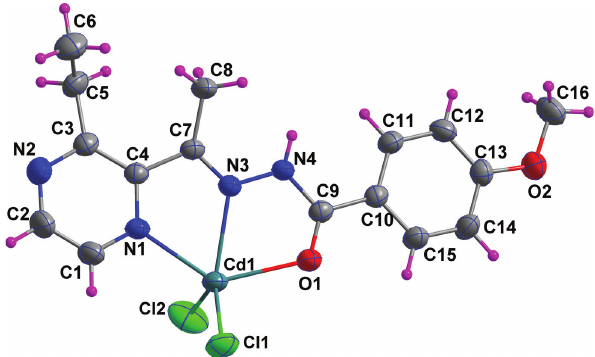
Table 2: Fractional atomic coordinates and isotropic or equivalent isotropic displacement parameters (Å 2